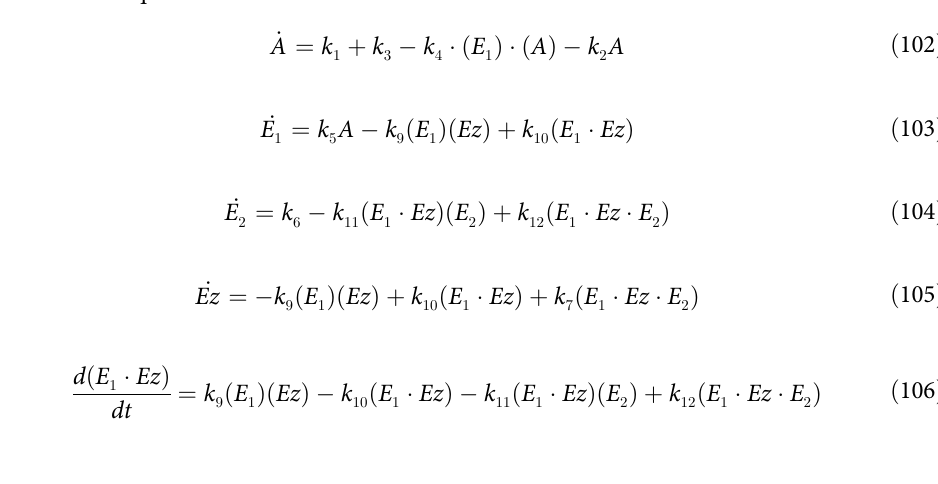
Motif 5 dual-E controller removing E